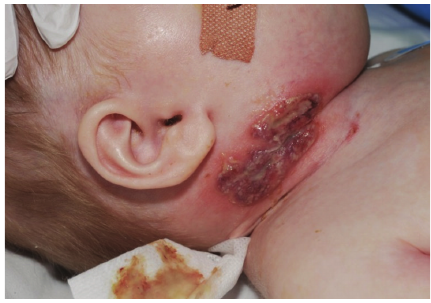
Figure 3: 29/12/14: healing with cribriform scarring following treatment with topical clobetasol